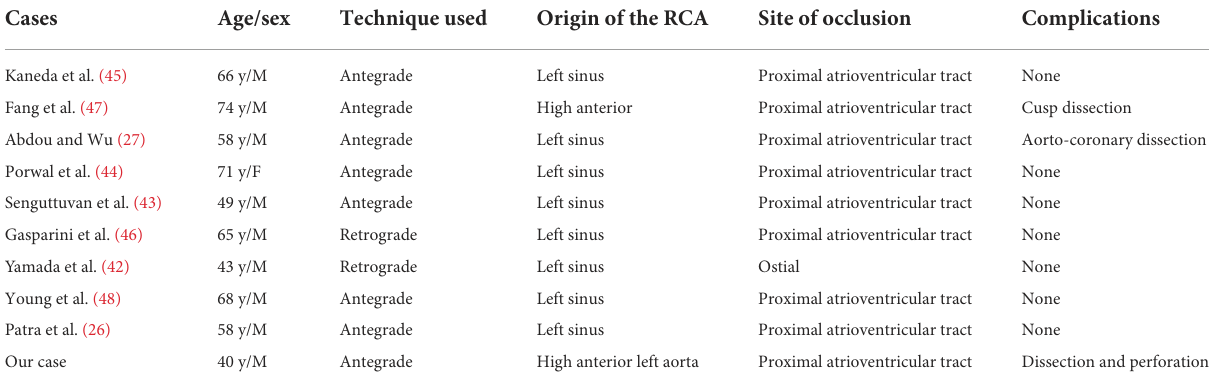
TABLE 1 ARCA CTO procedures reported in the